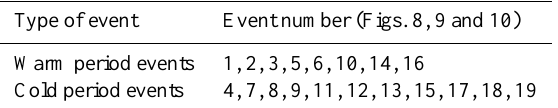
Fig. 6. The percentage of the events per time lag and for a radius of 10km.